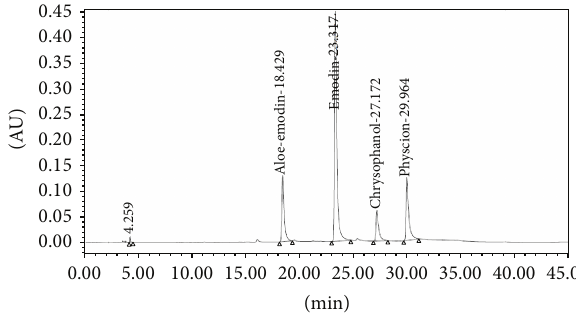
Figure 2: HPLC of isolated pure